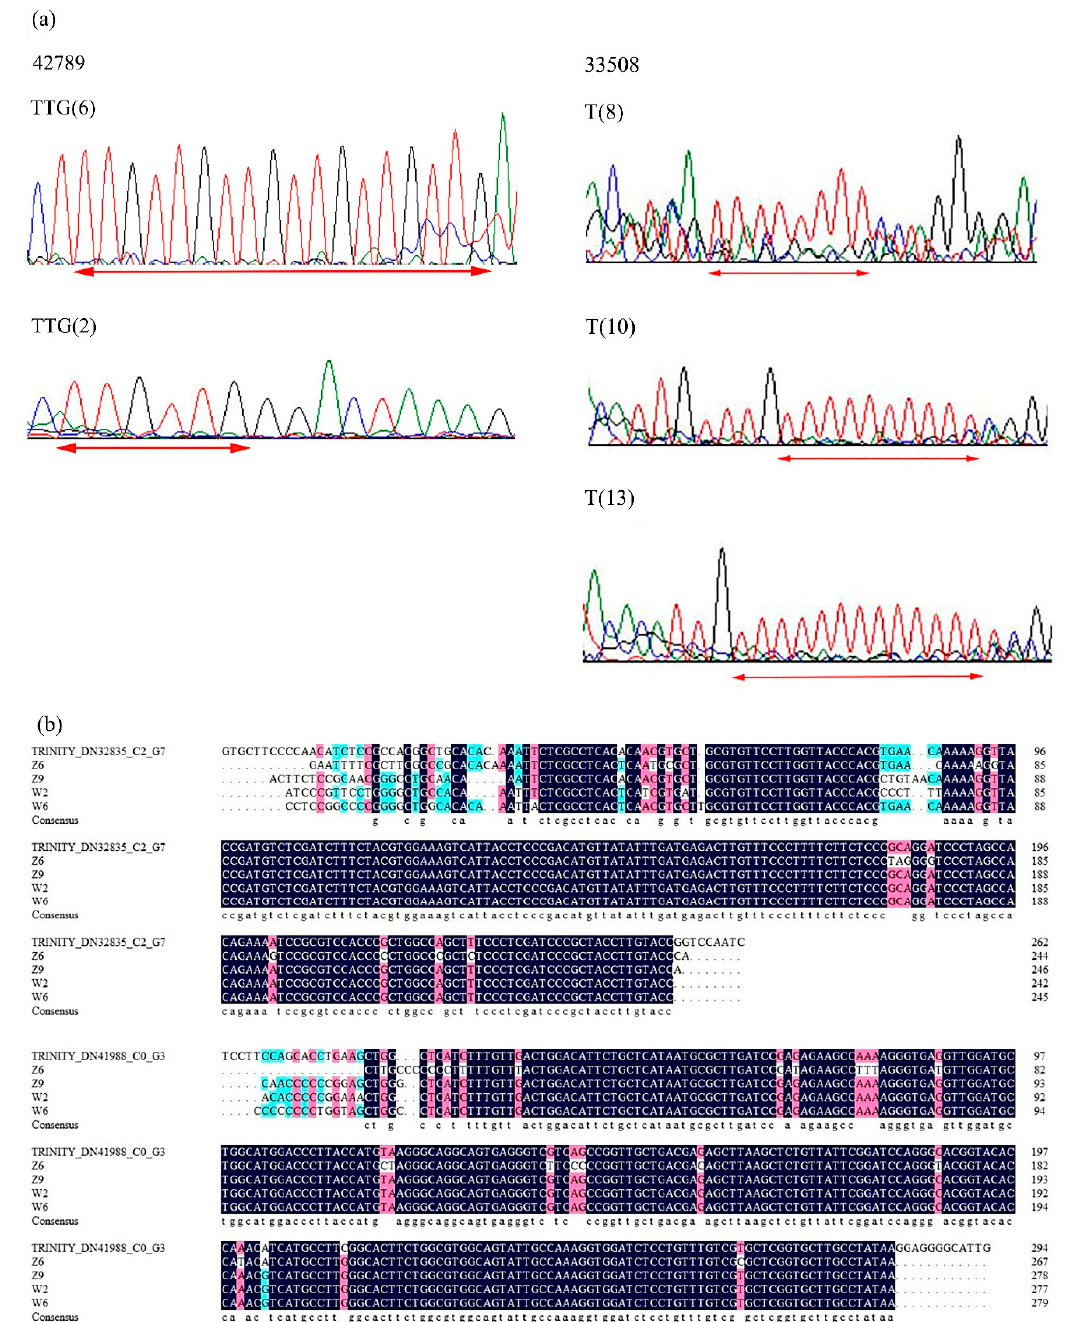
Figure 6. Multiple sequence alignment of RNA-seq and in the late-flowering and early-flowering E. sibiricus accessions. ( a ) Comparative electropherogram analysis of two EST-SSR loci (42789 and 33508) in early-flowering and late-flowering E. sibiricus accessions. ( b ) Alignment of sequences obtained from selected PCR bands amplified by two primers (32835 and